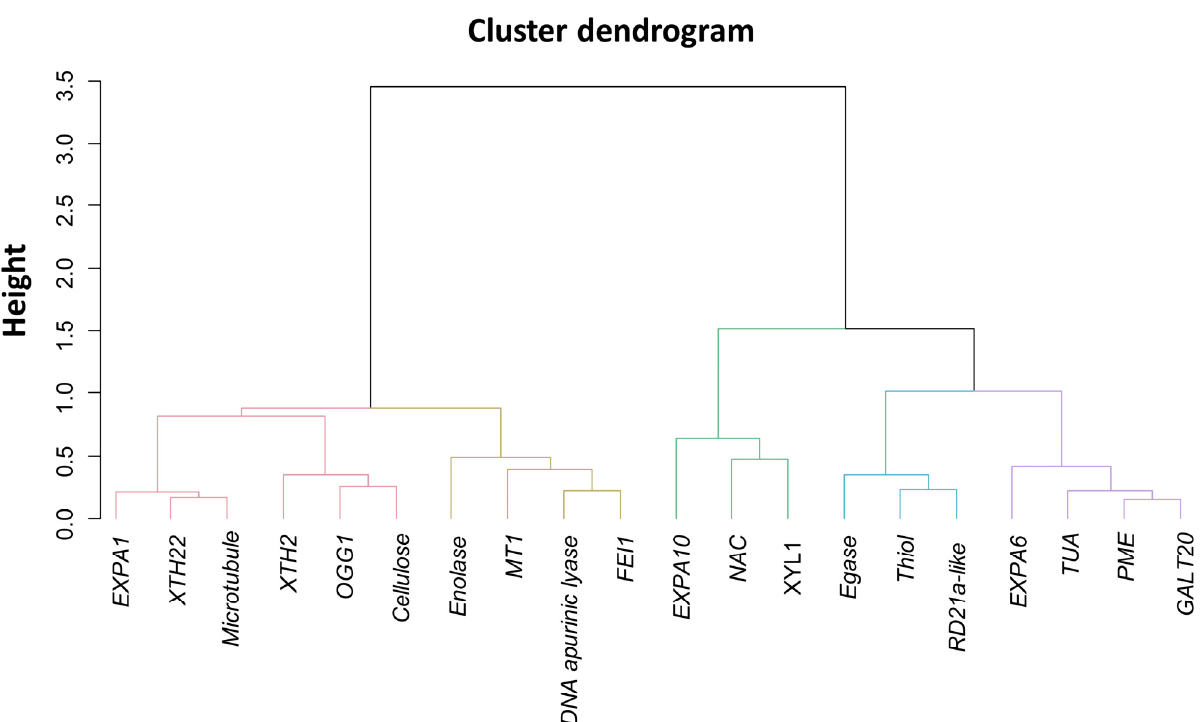
Figure 7. Gene clustering analyzed in soybean seed embryos during germination sensu stricto of two cultivars and their respective lots. N-glycosylase/DNA lyase OGG1 ( OGG1 ), DNA apurinic lyase , NAC domain-containing protein 8-like ( NAC ), Metallothionein-like protein 1 ( MT1 ), Enolase , Thiol protease aleurain-like ( Thiol ), Cysteine proteinase RD21a-like ( RD21a-like ), Alpha-xylosidase 1-like ( XYL1 ), Tubulin alpha-4 chain-like ( TUA ), Expansin-like A1 ( EXPA1 ), Expansin-A10-like ( EXPA10 ), Expansin-like A6 ( EXPA6 ), Xyloglucan endotransglucosylase/hydrolase 22 ( XTH22 ), Xyloglucan endotransglucosylase/hydrolase 2 ( XTH2 ), Endoglucanase 8-like ( Egnase ), Pectinesterase 3 ( PME ), LRR receptor-like serine/threonine-protein kinase FEI ( FEI1 ), Beta-1,3-galactosyltransferase 20 ( GALT20 ), 65-kDa microtubule-associated protein ( microtubule ), Cellulose synthase A catalytic subunit 2 ( cellulose ).